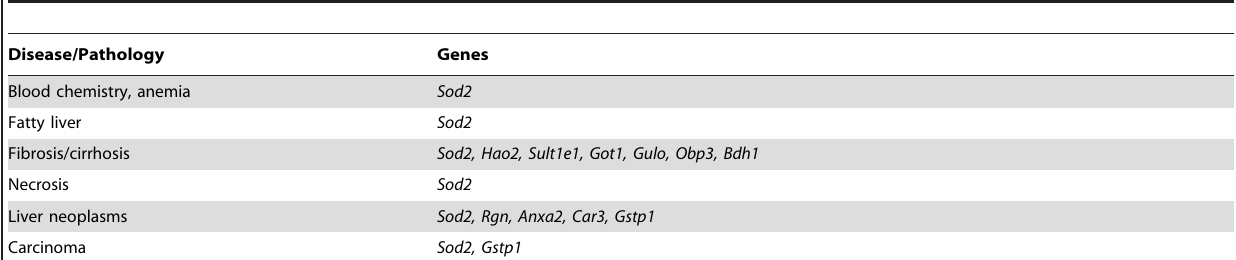
Table 6. Selected general liver injury signature genes with known disease annotations in the Comparative Toxicogenomics Database [20].